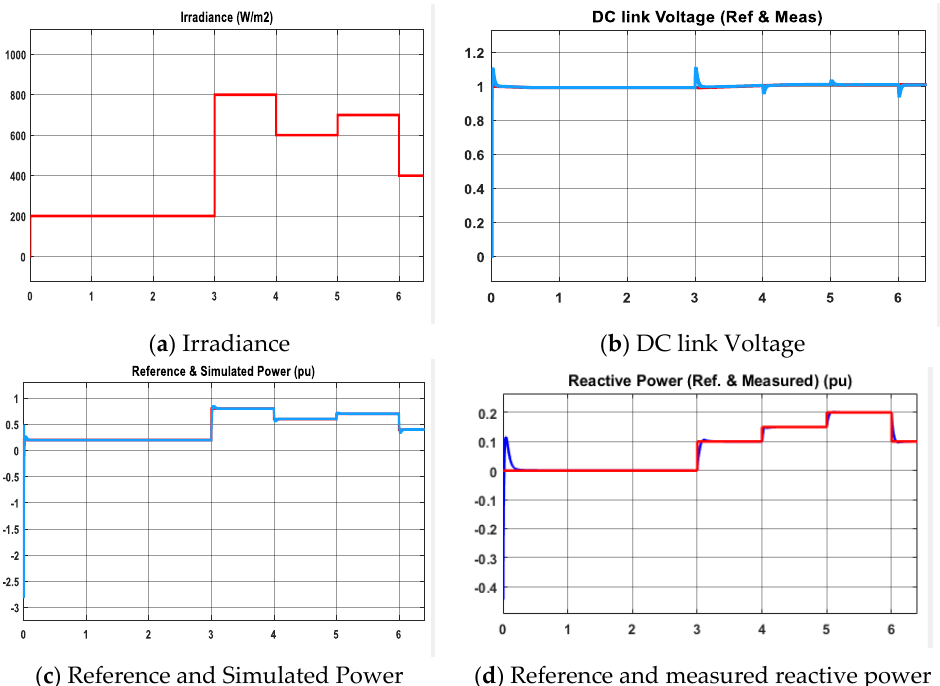
Figure 15. Performance of the proposed controller under different irradiance conditions.